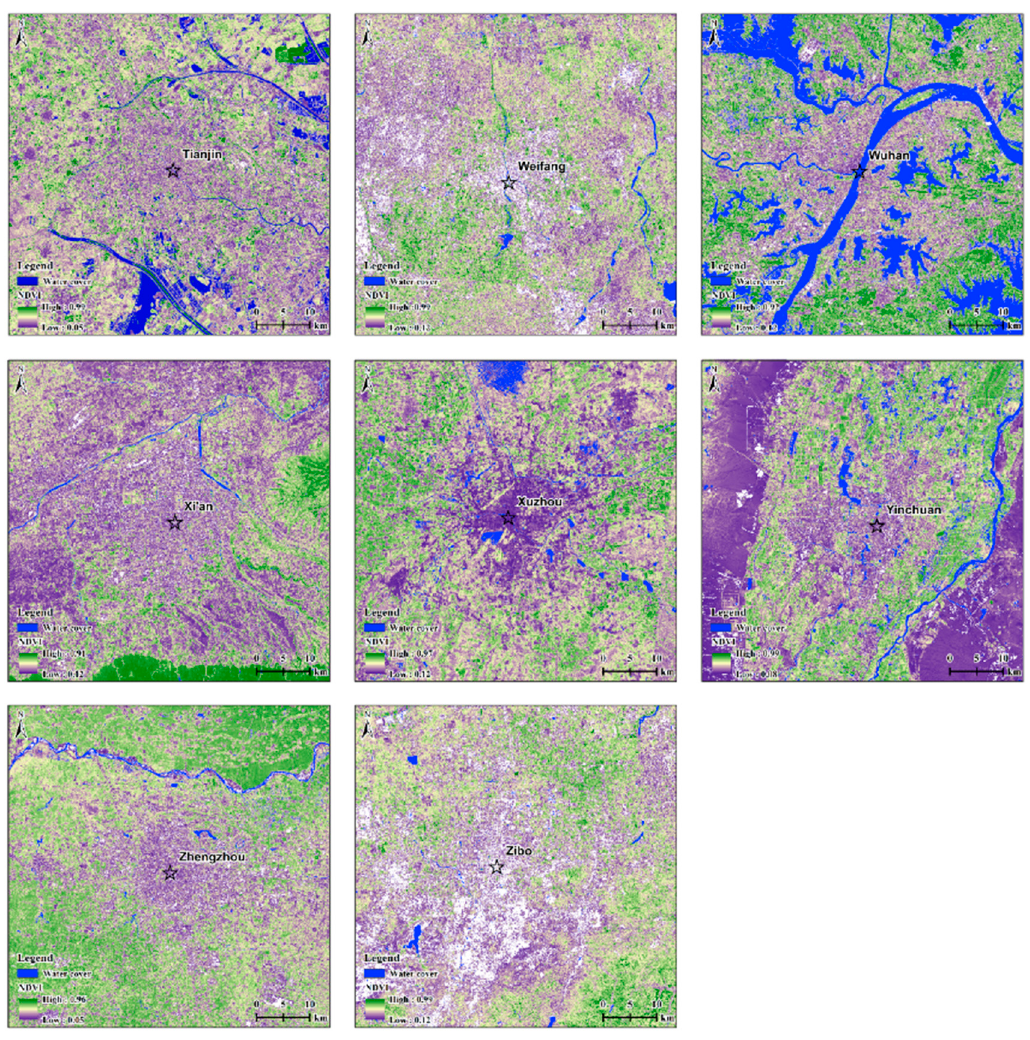
Figure A3. Map of the normalized difference vegetation index (NDVI) data and water cover (WC) data for the 32 Chinese cities.